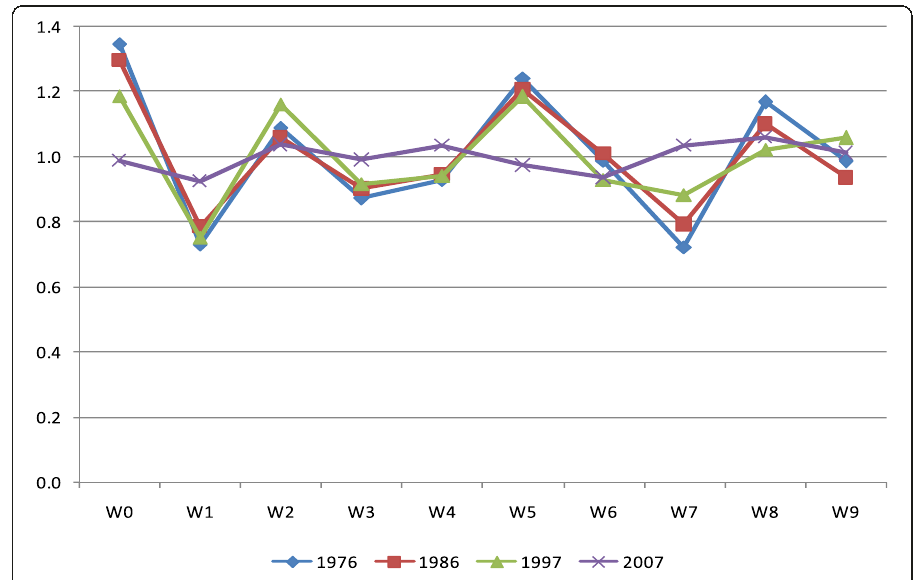
Fig. 2 Digit-specific modified Whipple ’ s indices ( W i ) for women aged 21 – 52, Swaziland, 1976 – 2007 PHC. Source: published raw data from Swaziland